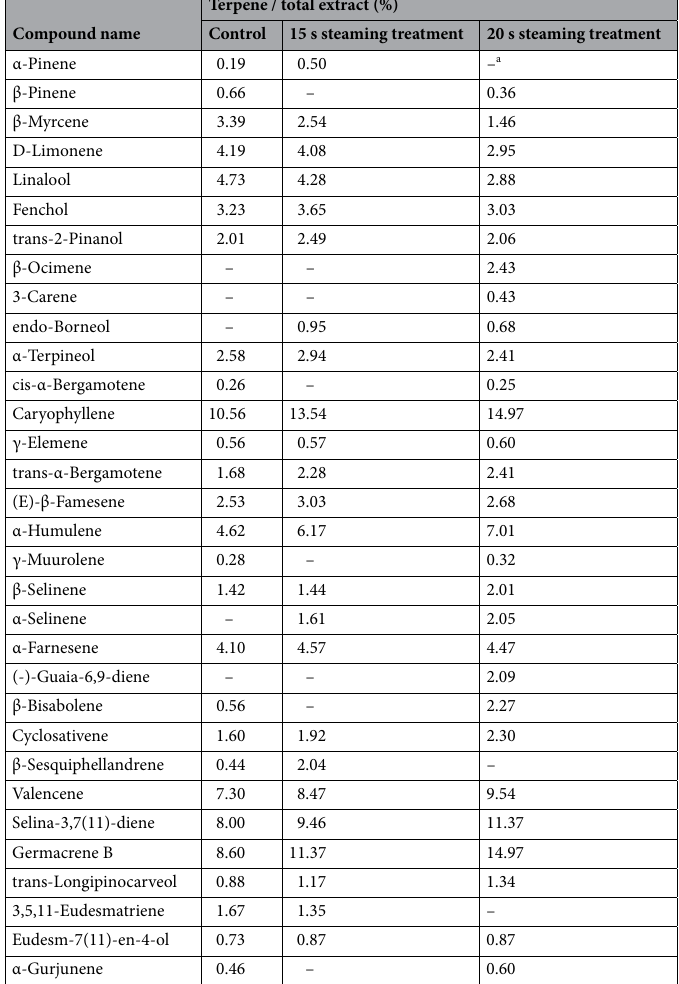
Table 2. List of terpenes and terpenoids and their relative amounts detected by GC–MS from the first noncommercial experiment. a Concentration below detection